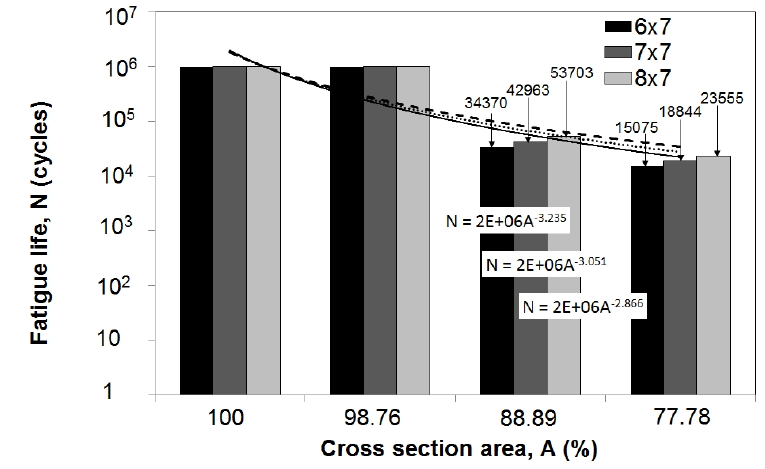
Figure 6. The remaining fatigue life for 6 × 7, 7 × 7, and 8 × 7 wire ropes with full and reduced cross-section areas.